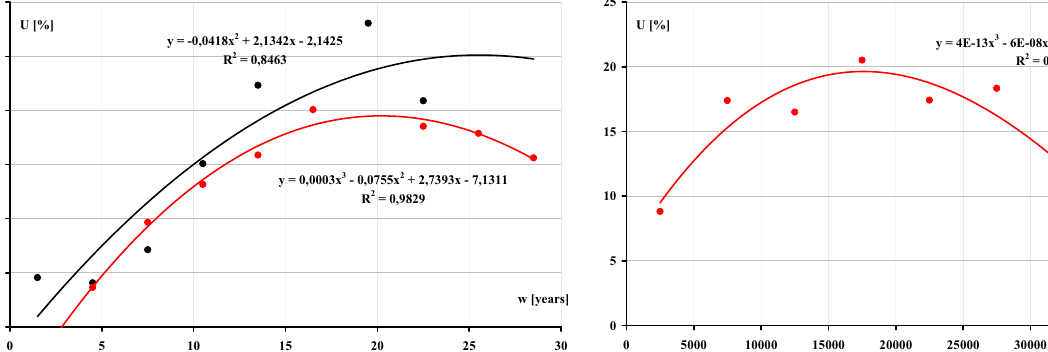
Figure 8: Dependence of the share of vehicles with faults among vehicles in a given age range for vehicles purchased domestically ( black line ) and imported ( red line ) .